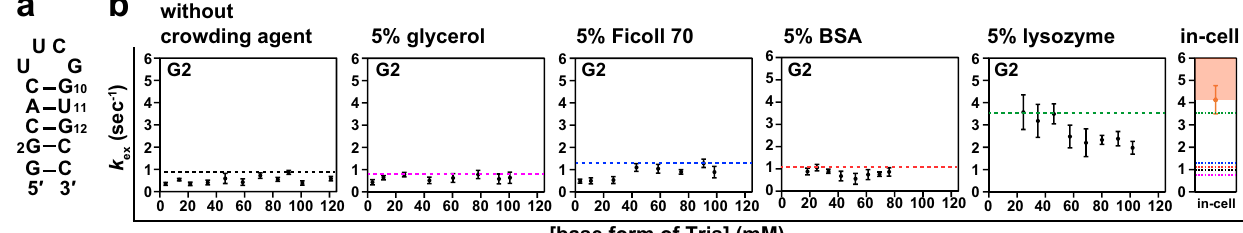
Fig. 4 |AnalysisoftheexchangeofiminoprotonsoftheRNAhairpin structure in the presence of crowding agents. a Secondary structure of fully 2 ′ - O -methy- lated hpRNA14. b Comparison of k open values for G2 of hpRNA14 between in-cell conditions and in vitro conditions in either the absence or presence of a crowding agent(glycerol,Ficoll,BSA,andlysozyme).Thedashedlinesindicatethemaximum k ex values for G2 obtained under in vitro conditions in the absence (black) and presenceofeitherglycerol(pink),Ficoll(blue),BSA(red),orlysozyme(green).Each maximum k ex value equals k open under individual conditions. The orange shading